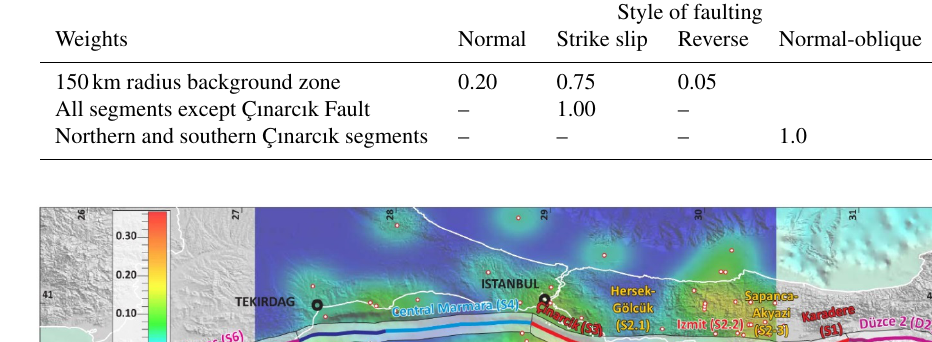
magnitude units to M char for each source in each logic tree branch (Table